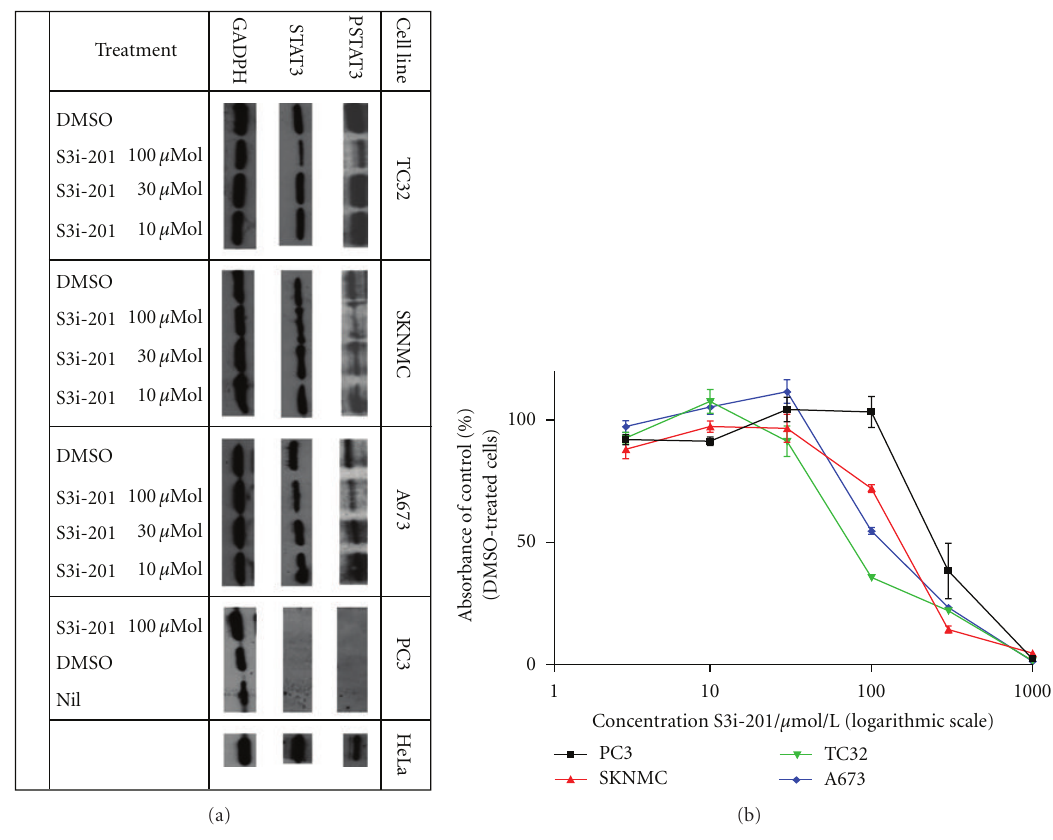
Figure 2: Phosphorylated STAT3 is present in Ewing’s cell lines, but not PC3, which can be diminished by S3i-201 and reduces viability in ESFT cell lines. (a) Western blot analysis; Lysates from IL-6-stimulated and -unstimulated HeLa cells served as positive controls for P-STAT3 and total STAT3, respectively. The GADPH band is representative of loading in each lane. Data are representative of at least three independent experiments per cell line. (b) Cell viability is determined by MTT assay. Data are representative of at least three independent experiments per cell